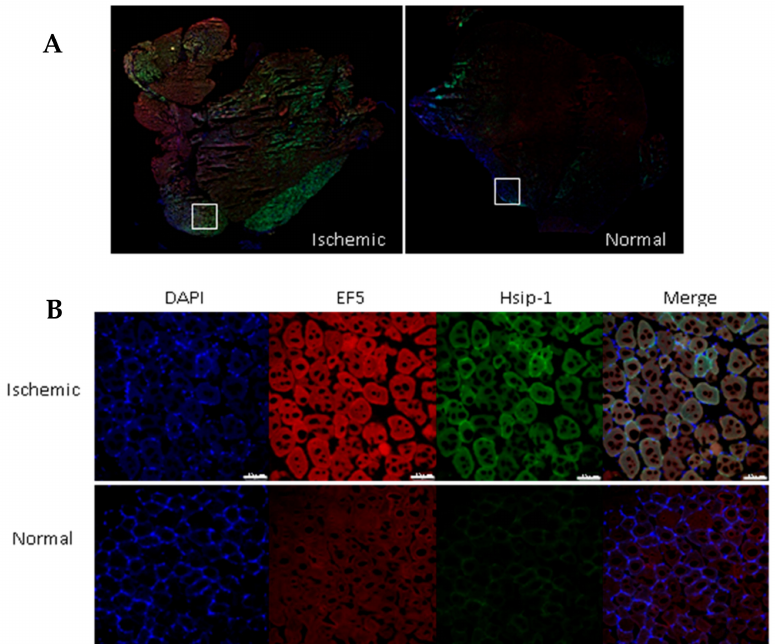
Figure 4. Immunofluorescence staining of hindlimb sections. ( A ) Fluorescence images of ischemic and normal tissue. Tissue imaging was performed with a confocal microscope. Original magnification: 100 × . ( B ) Red indicates EF5 (hypoxia detection), green indicates HSip-1 (H 2 S detection), and blue indicates DAPI (nuclei). Original magnification: 400 × ; scale bars, 75 µ